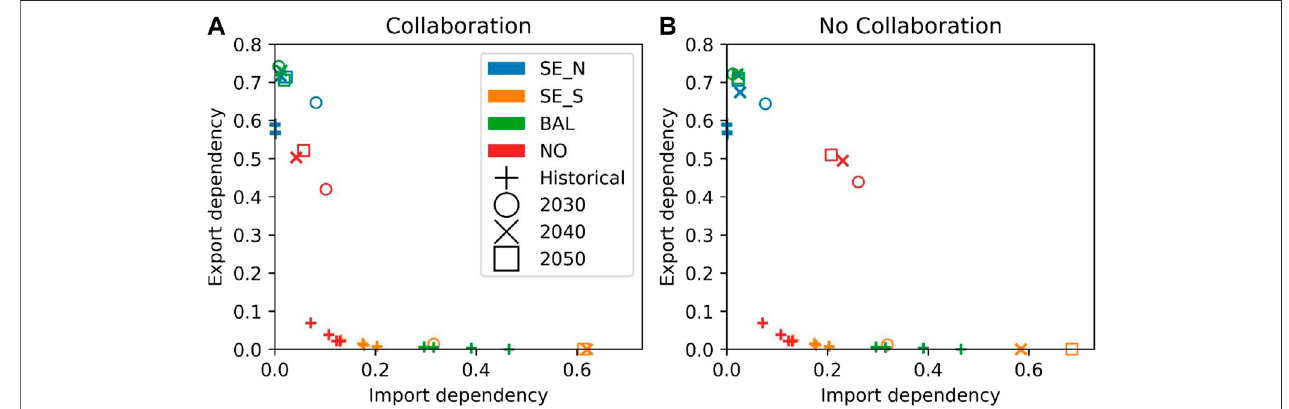
FIGURE7| Theannualexportandimportdependenciesforthemodelledperiodandtheperiodof2016 – 2019( “ historical ” )inselectedregions(differentcolours)in: (A) the Collaboration scenario; and (B) the No Collaboration scenario. The results for all the regions are presented in Supplementary Appendix Tables A4.11.1, A4.11.2